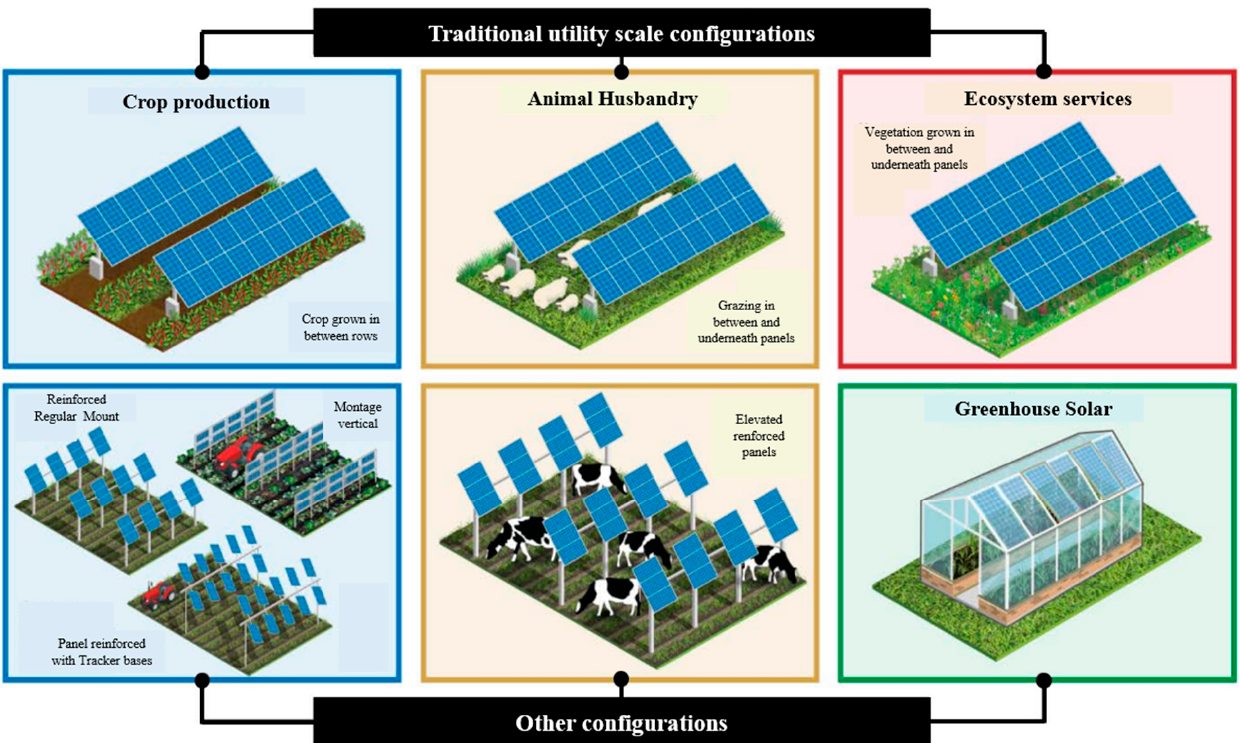
Figure 1. The different agrivoltaic systems [29].